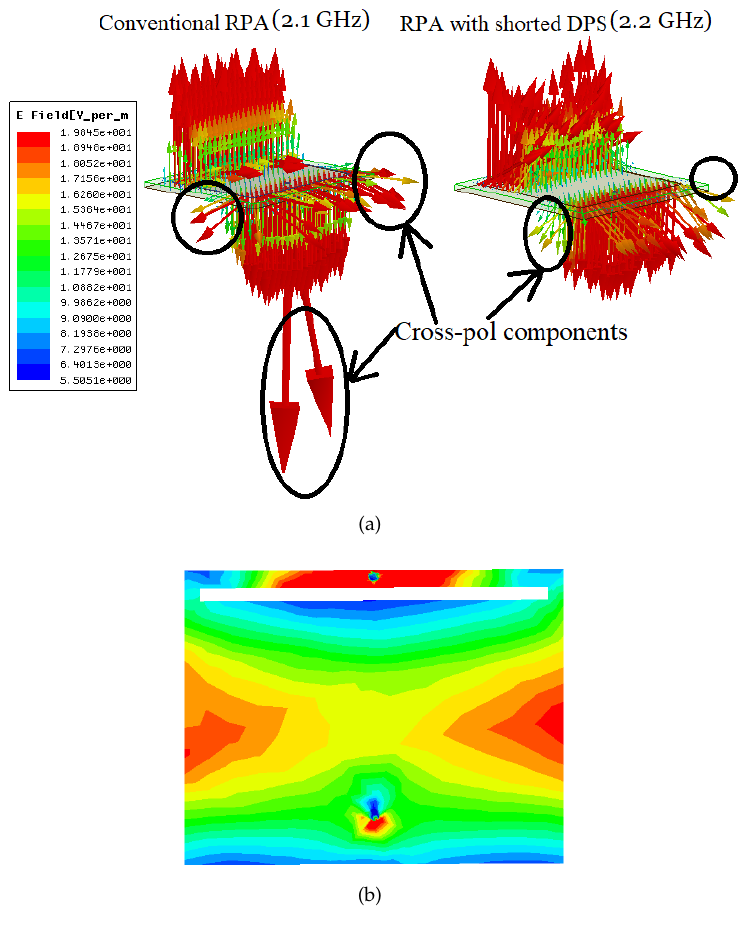
Figure 6. Cross-polarization analysis ( a ) Dominant mode electric field vectors of a conventional and the proposed design ( b ) Surface current distribution on the proposed antenna.